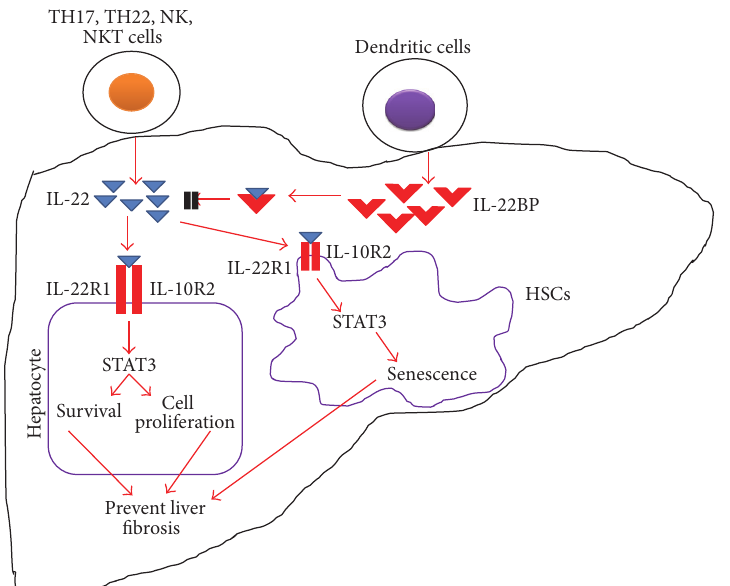
Figure 2: IL-22 and IL-22BP interaction in regulation of liver fibrosis. IL-22 is produced by a number of cells (activated T cells and NK cells) and helps prevent liver fibrosis by increasing the survival rate of hepatocytes and promoting HSCs senescence and by binding to IL-22R complex. IL-22BP has more affinity for IL-22 than IL-22R1 and hence it prevents IL-22 binding to IL-22R complex and checks antifibrotic activity when binding to